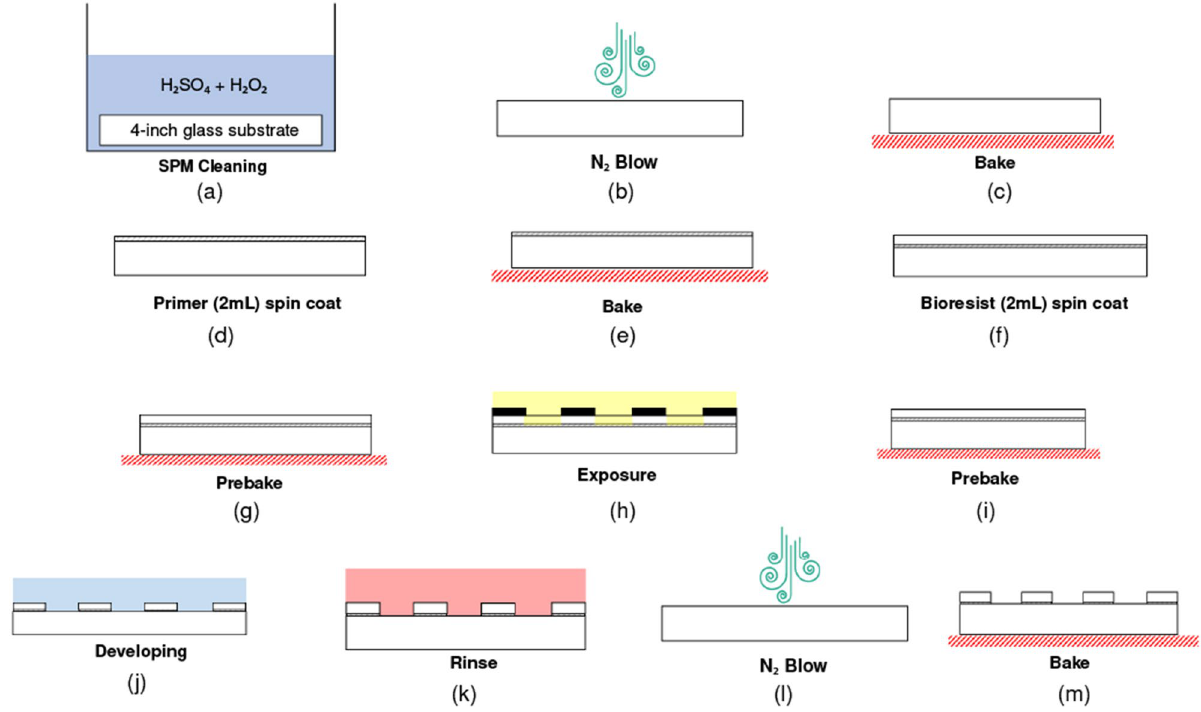
Figure 2. Photolithography process of bioresist hydrogel on a glass substrate. ( a ) The wafer was cleaned in SPM solution (H 2 SO 4 and H 2 O 2 solution in 1:1 ratio) for 15 min. ( b ) N 2 blow. ( c ) The substrate was baked at 180 °C for 10 min and then was brought to room temperature for 5 min. ( d ) Primer was spin-coated with a slope for 5 s; spun at 500 rpm for 20 s; slope for 5 s; spun for 60 s at 3000 rpm; slope for 10 s. ( e ) The substrate was baked in the following configurations: 65 °C for 2 min; 120 °C for 10 min; 65 °C for 2 min; room temperature for 5 min. ( f ) Bioresist was spin-coated with a 5 s slope; 500 rpm for 20 s; 5 s slope; 3000 rpm for 60 s; and slope for 10 s. ( g ) The bioresist was prebaked at 65 °C for 2 min, at 100 °C for 20 min, at 65 °C for 2 min, and at room temperate for 5 min. ( h ) The light intensity of UV exposure was 2000 mJ/cm 2 . ( i ) The bioresist was baked after the UV exposure at 65 °C for 2 min, at 120 °C for 20 min, at 65 °C for 2 min, and at room temperature for 5 min. ( j ) The substrate was developed in pure water at room temperature and was shaken at 60 rpm twice, 10 min each. ( k ) The substrate was then rinsed in pure water at 60 °C for 20 min. ( l ) N 2 blow was performed to dry the substrate. ( m ) Finally, it was baked at 60 °C for 20